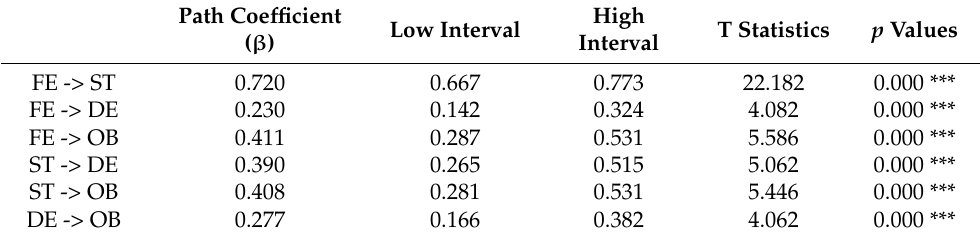
Table 7. Structural model analysis.